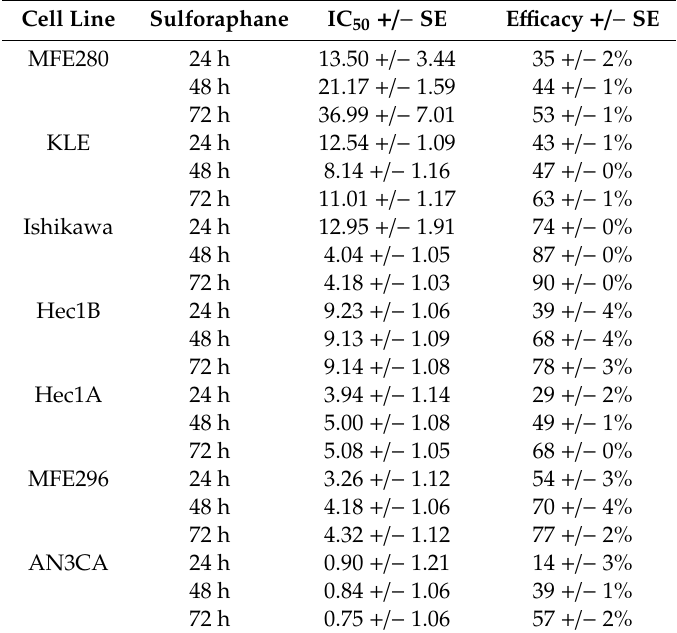
Table 1. Sulforaphane potencies ( µ M) and e ffi cacies (maximal % growth inhibition) against human endometrial cancer cell